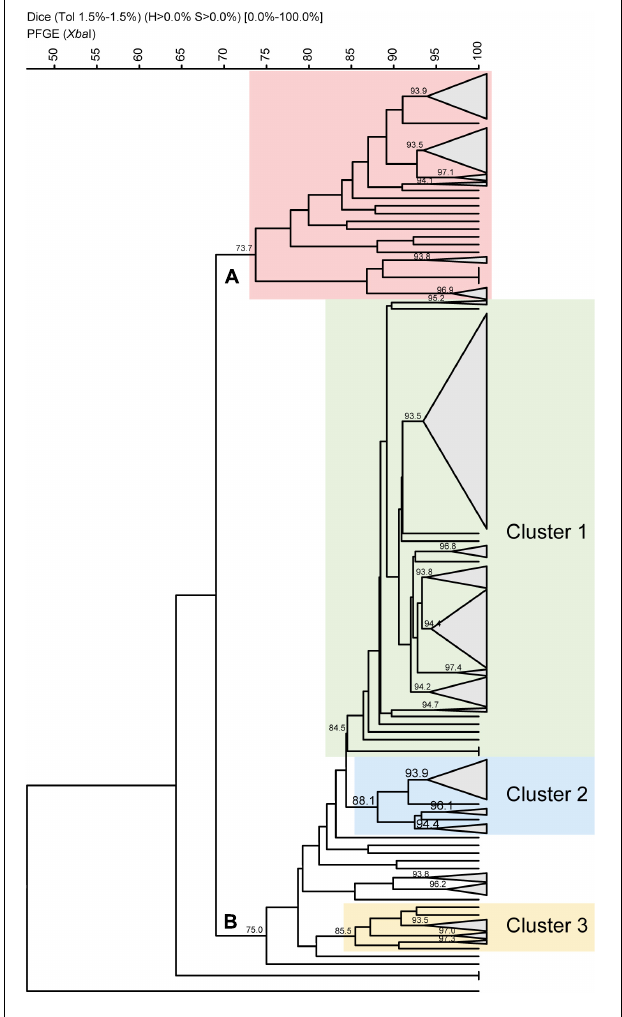
FIGURE 4 | Dendrogram based on Dice coefficients of similarity for 276 Chilean Shigella sonnei strains by pulsed-field gel electrophoresis patterns. The dendrogram was constructed by UPGMA (GelCompar II). Shown are two pulsegroups (A,B) with a similarity of 69.1%. Twenty-two pulsetypes were defined with a similarity of > 93.5%. Within pulsegroup A, all the strains belong to periods A and B, and most of them harbored dfrA8 as TMP resistance marker. Pulsegroup B comprises 214 strains divided in three clusters. Within cluster 1, there are 144 SRL and SRL/ dfrA14 strains. Cluster 2 contains 25 strains, of which 21 are NAL-resistant strains harboring class 2 integron. Cluster 3 is composed of 13 strains, of which 11 carry class 2 integron, but they are NAL-sensitive